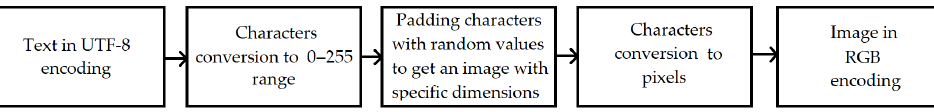
Figure 2. Text to image conversion